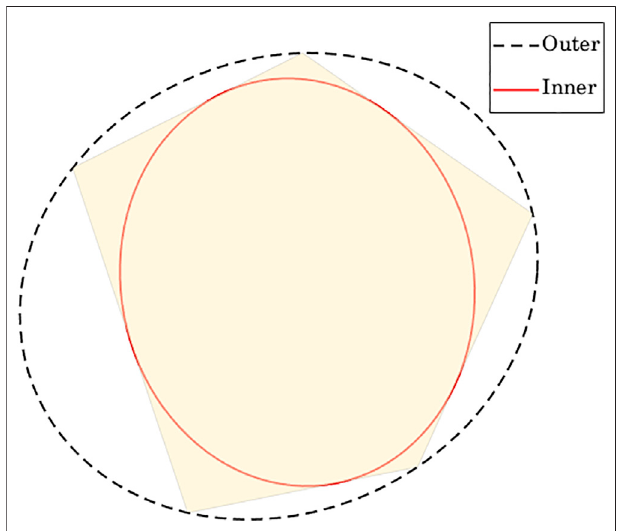
FIGURE 2 | A polytope with inner and outer Löwner-John